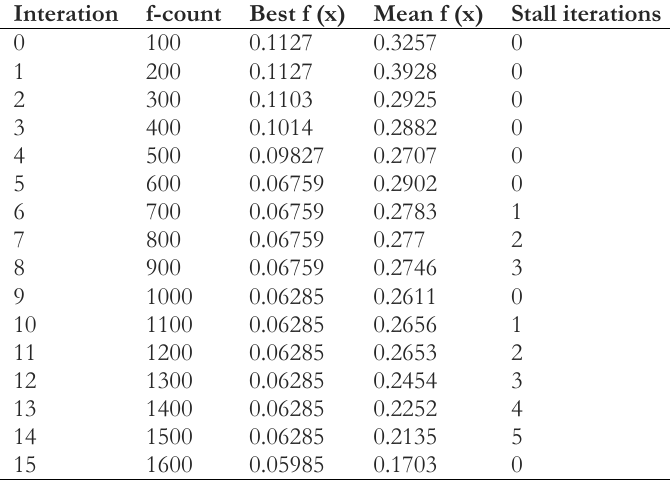
Table 4. Results obtained using optimized upper MFs of